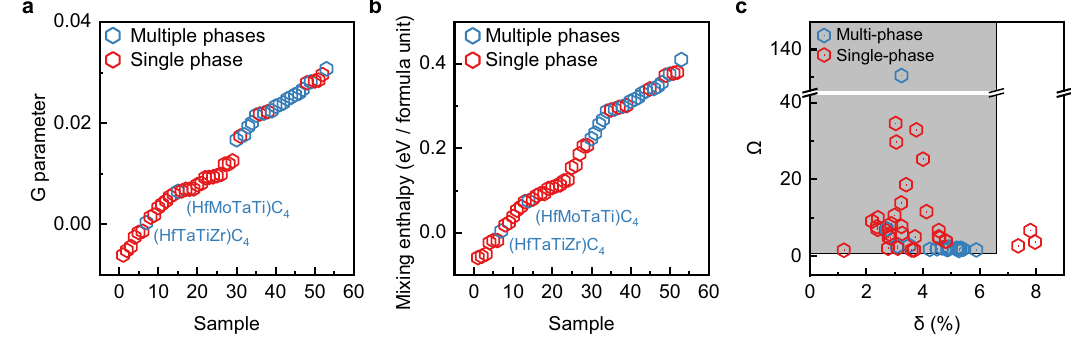
Fig. 8 Conventional descriptors for HECCs. a Gibbs free energy parameter, b mixing enthalpy, and c Ω – δ and (HfMoTaTi)C 463 are found to be 0.004 and 0.075 eV per formula unit, respectively.